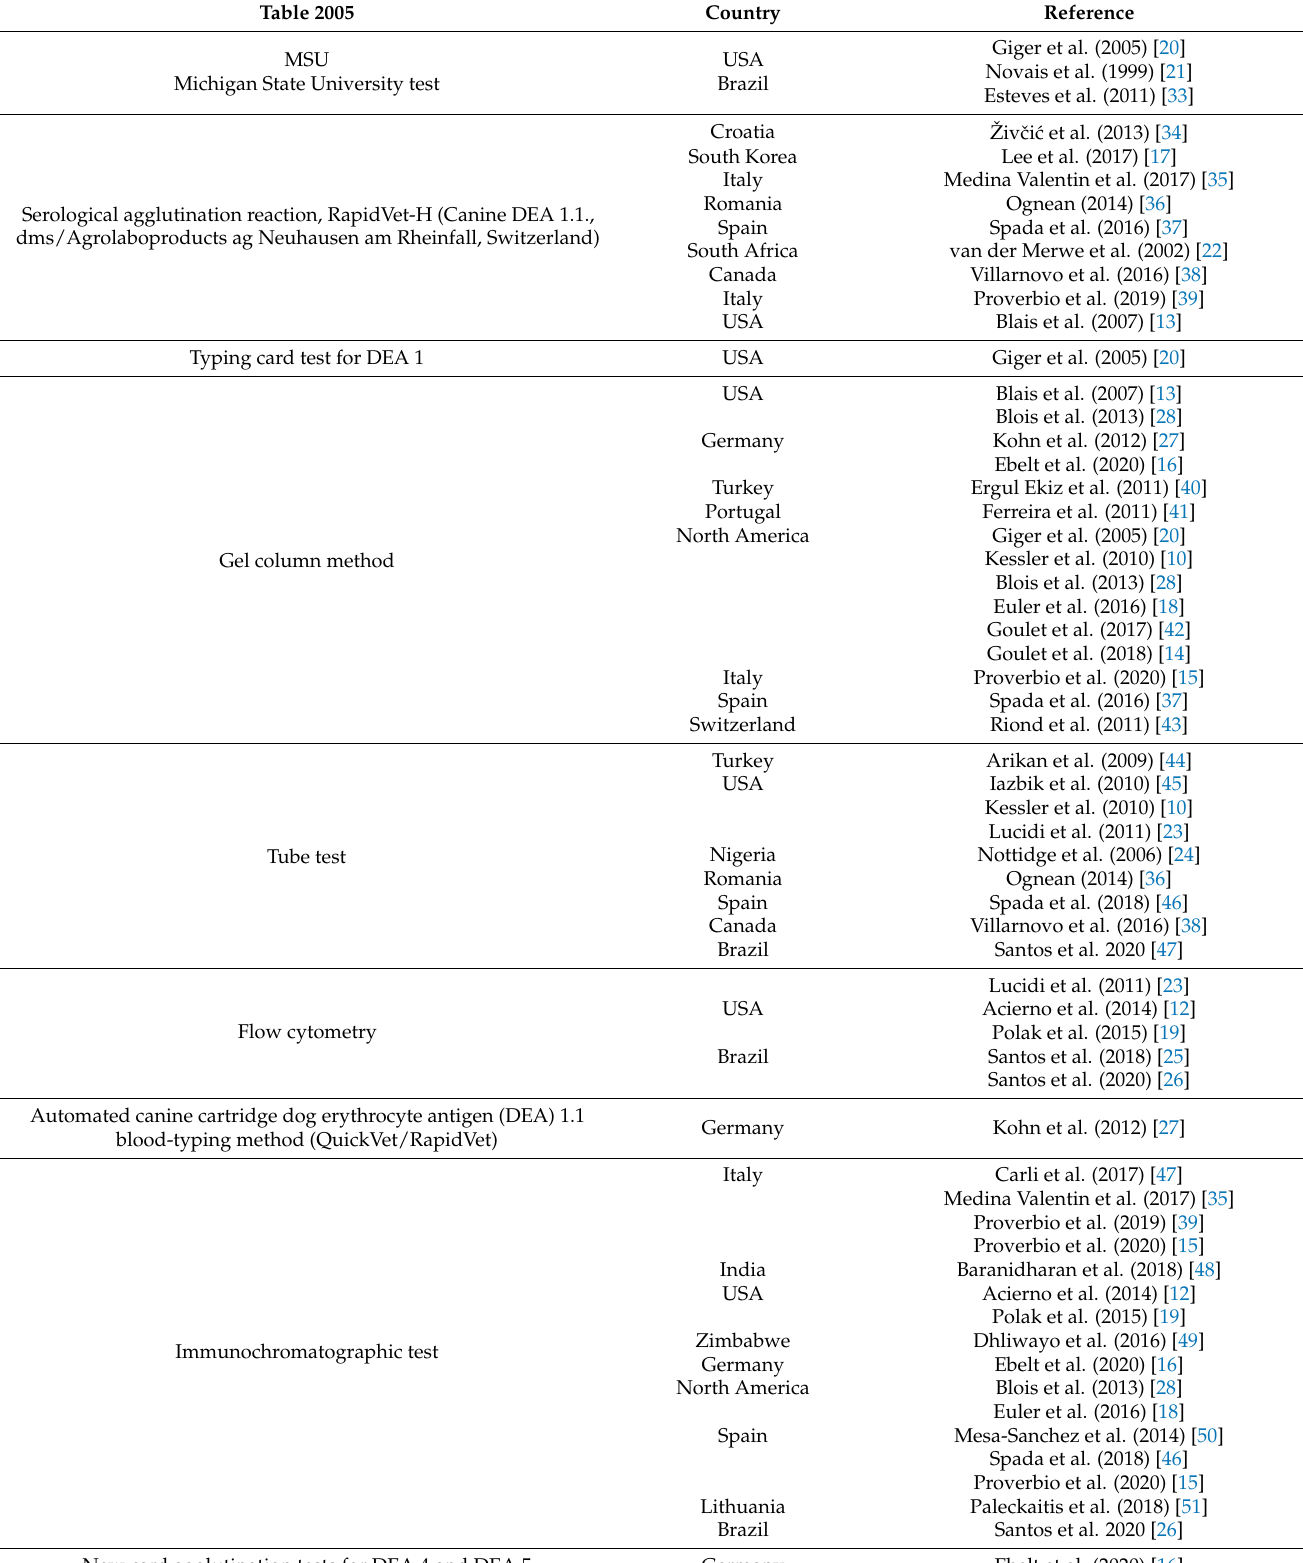
Table 1. Methods used to determine canine blood groups in different countries. All these studies were published between 1999 and 2020. Table